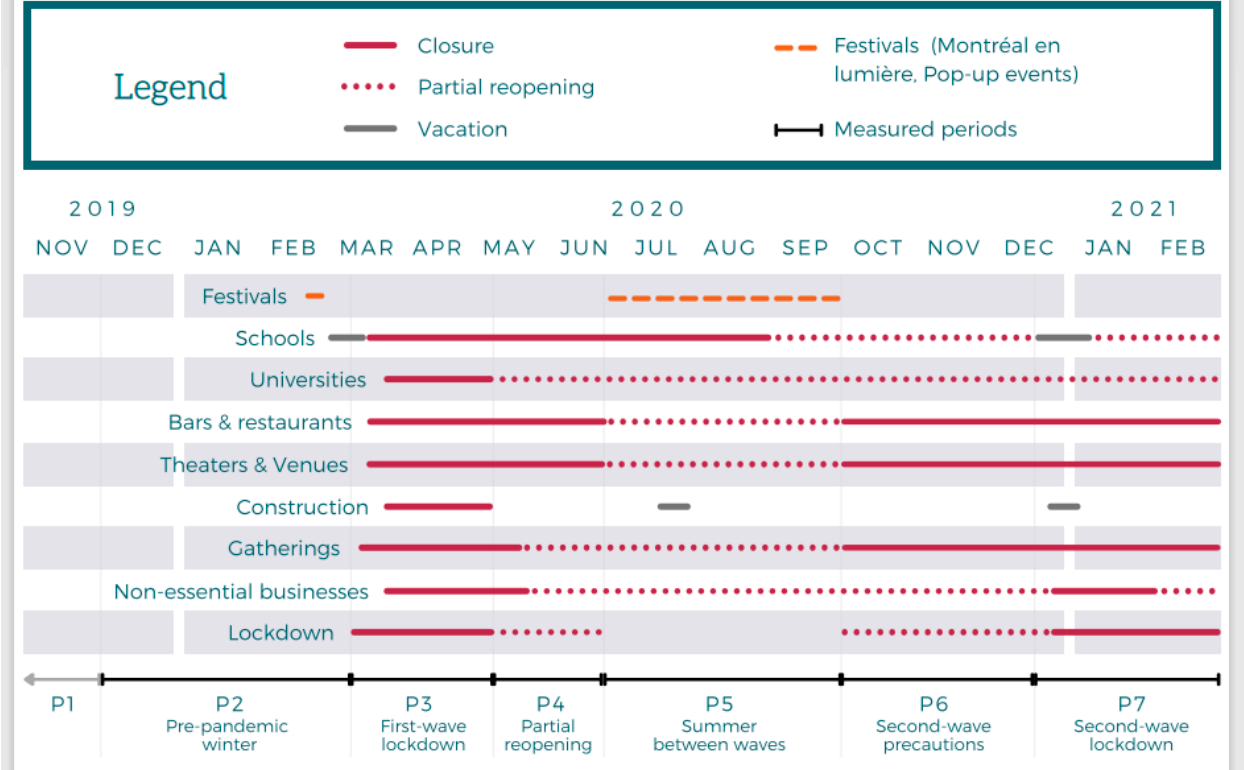
Figure 2. Timeline of key events and closures during the study’s time period.